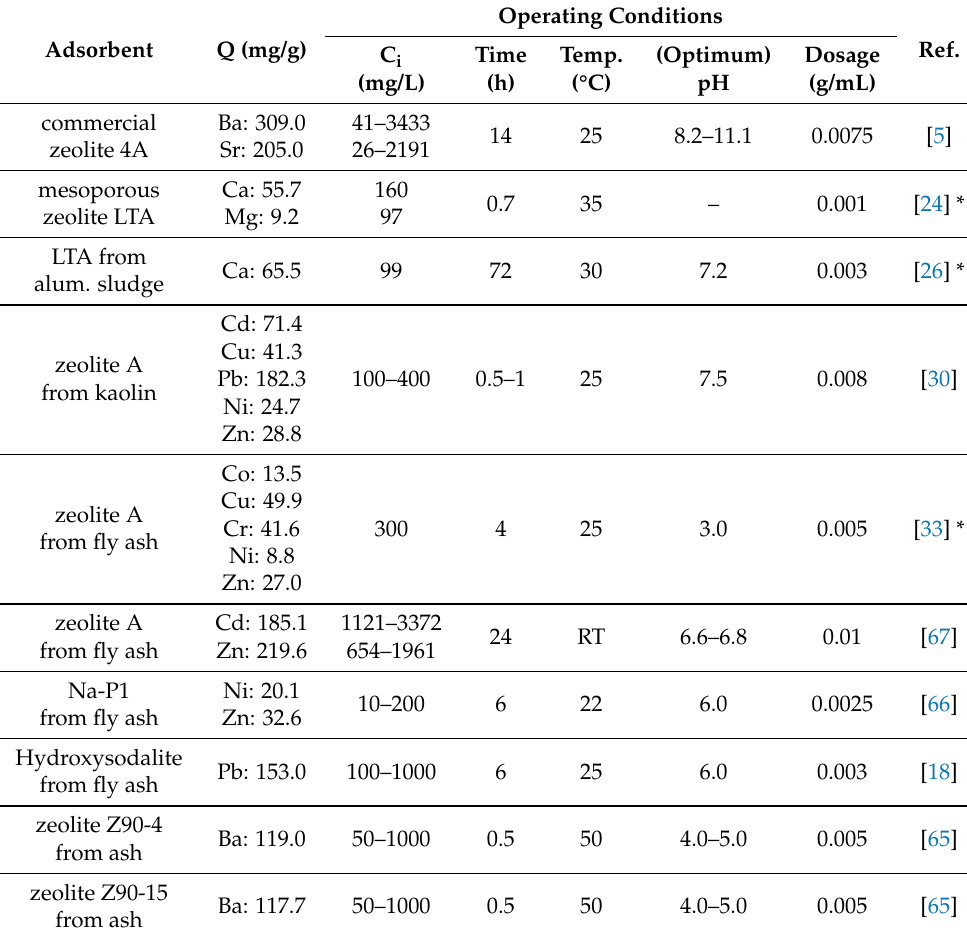
Table 6. Comparison of the sorption capacities of various materials for the removal of Me ions from solution under comparable operational conditions. *—indicates Q-values derived from competi- tive/multicomponent ion sorption experiments.